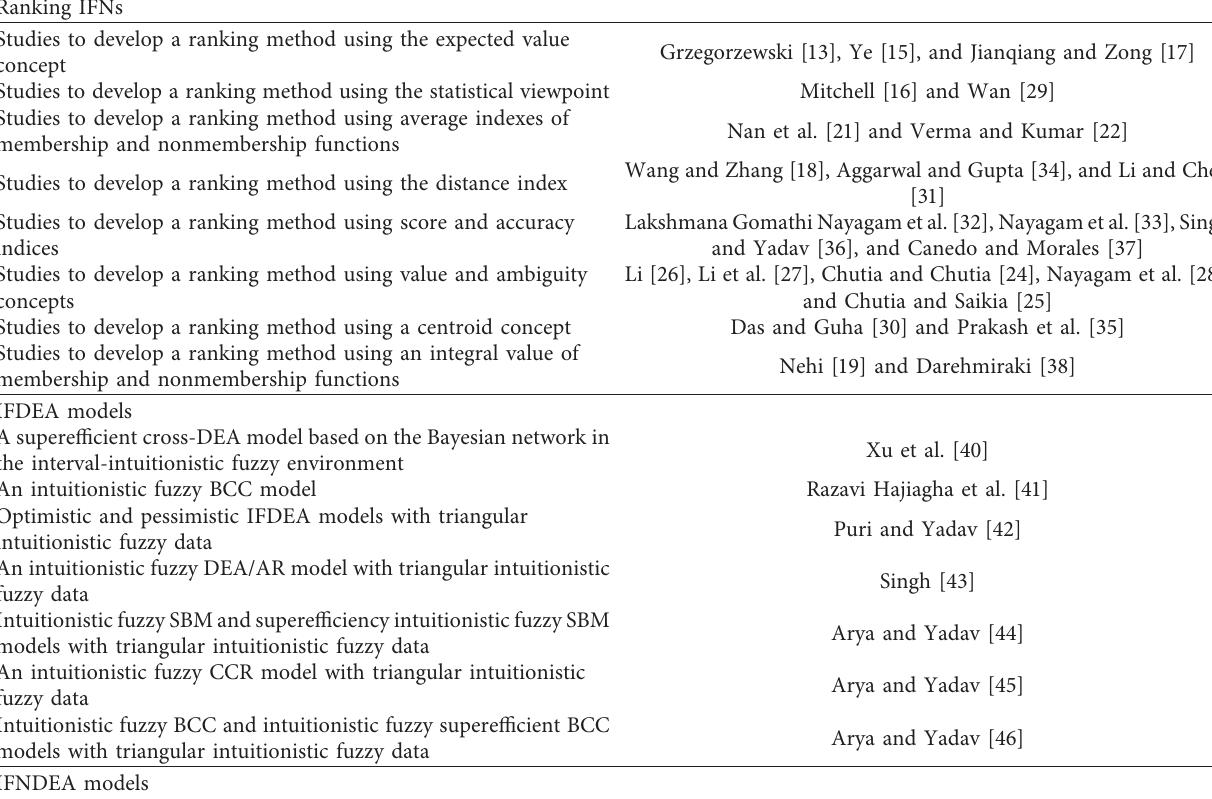
Table 1: Summary of the literature